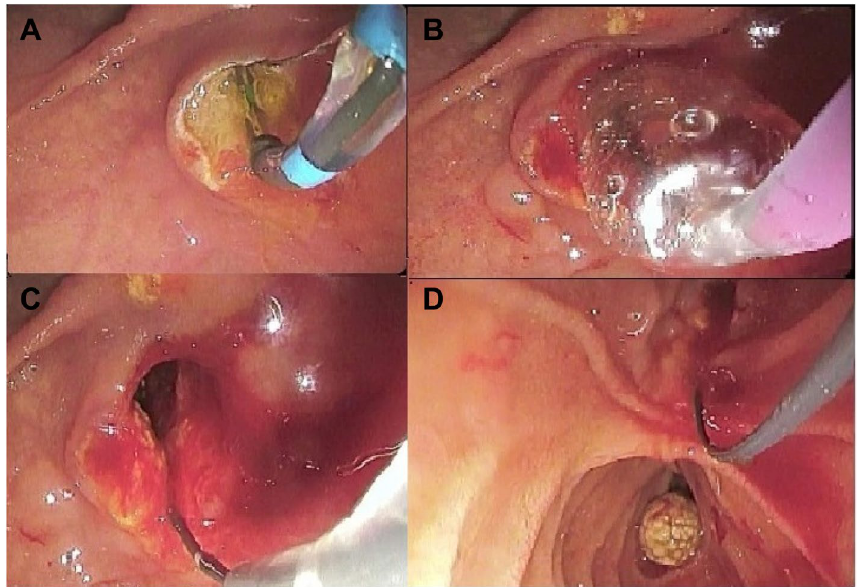
Fig. 3 Endoscopic view of EPLBD following papillary precut. A Limited precut of papilla. B Large balloon inflation within the papillary orifice. C Markedly dilated papillary orifice after EPLBD. D A large CBD stone was removed using a retrieval balloon catheter through the dilated papillary